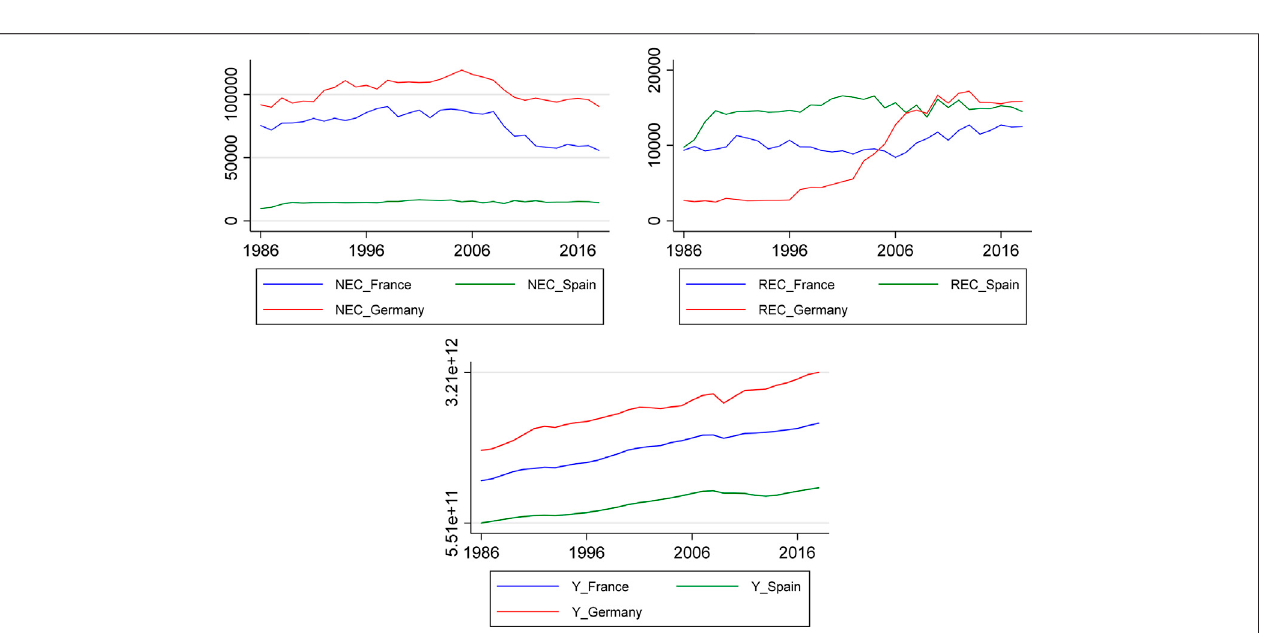
FIGURE1| Nuclear( NEC ),renewableenergyconsumption(REC)and economicgrowth (GDP)series inFrance,SpainandGermany(1983 – 2019). Nuclear energy use series for the left panel, renewable energy consumption series for the right panel, GDP series for the bottom panel. Sources: our elaborations based on IEA (2009) and WDI (2020)